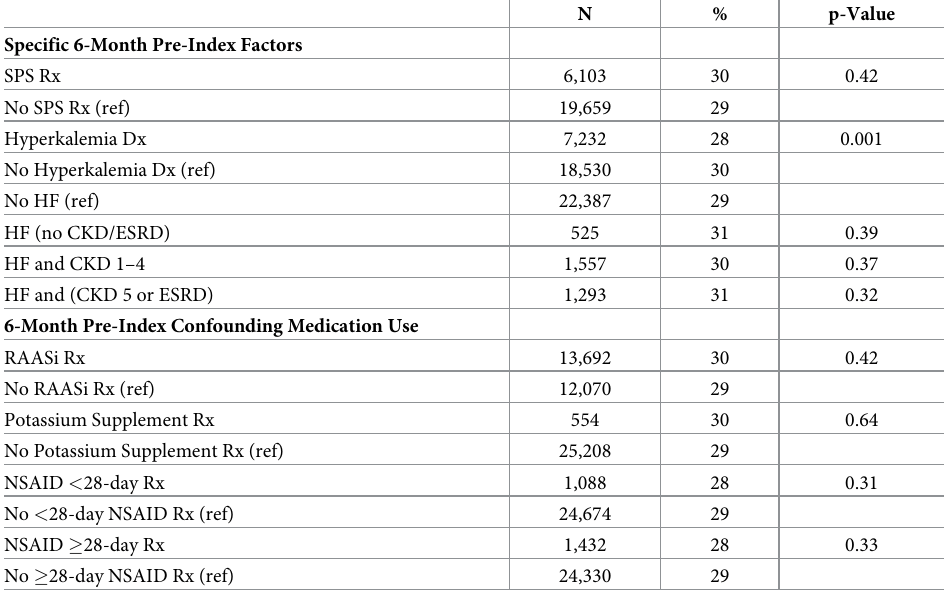
(ref) indicates categorical reference group Abbreviations: CKD, chronic kidney disease; Dx, diagnosis; ESRD, end-stage renal disease; HF, heart failure; NSAID, nonsteroidal anti-inflammatory drug; RAASi, renin-angiotensin aldosterone system inhibitor; Rx, prescription; SPS, sodium polystyrene